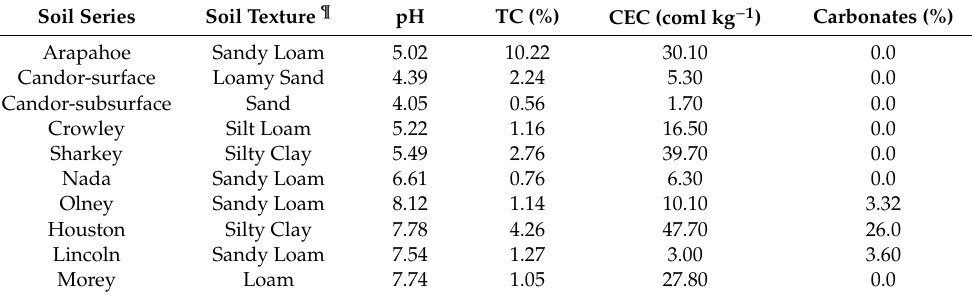
Table 1. Soil texture and selected chemical soil